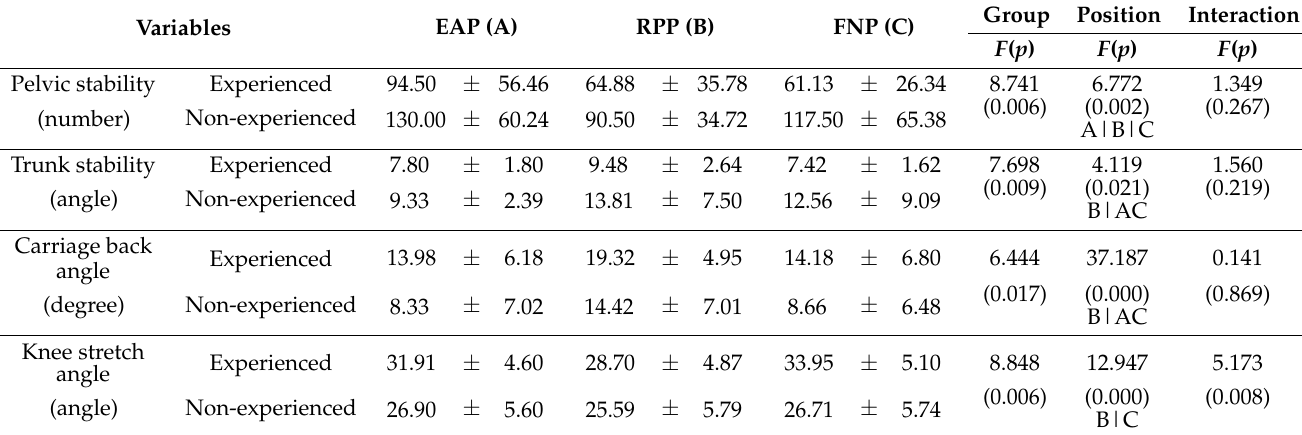
Table 3. Kinematic analysis during the knee stretch exercise.